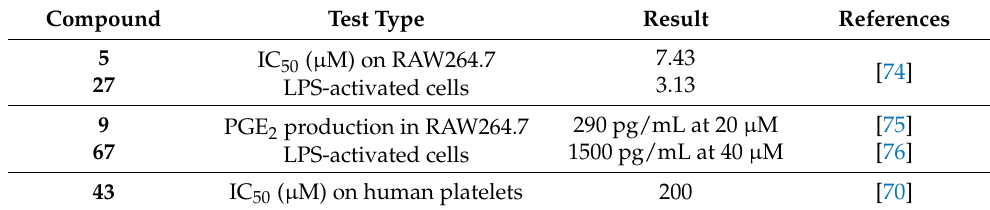
Table 5. Inhibition of PGE 2 production.